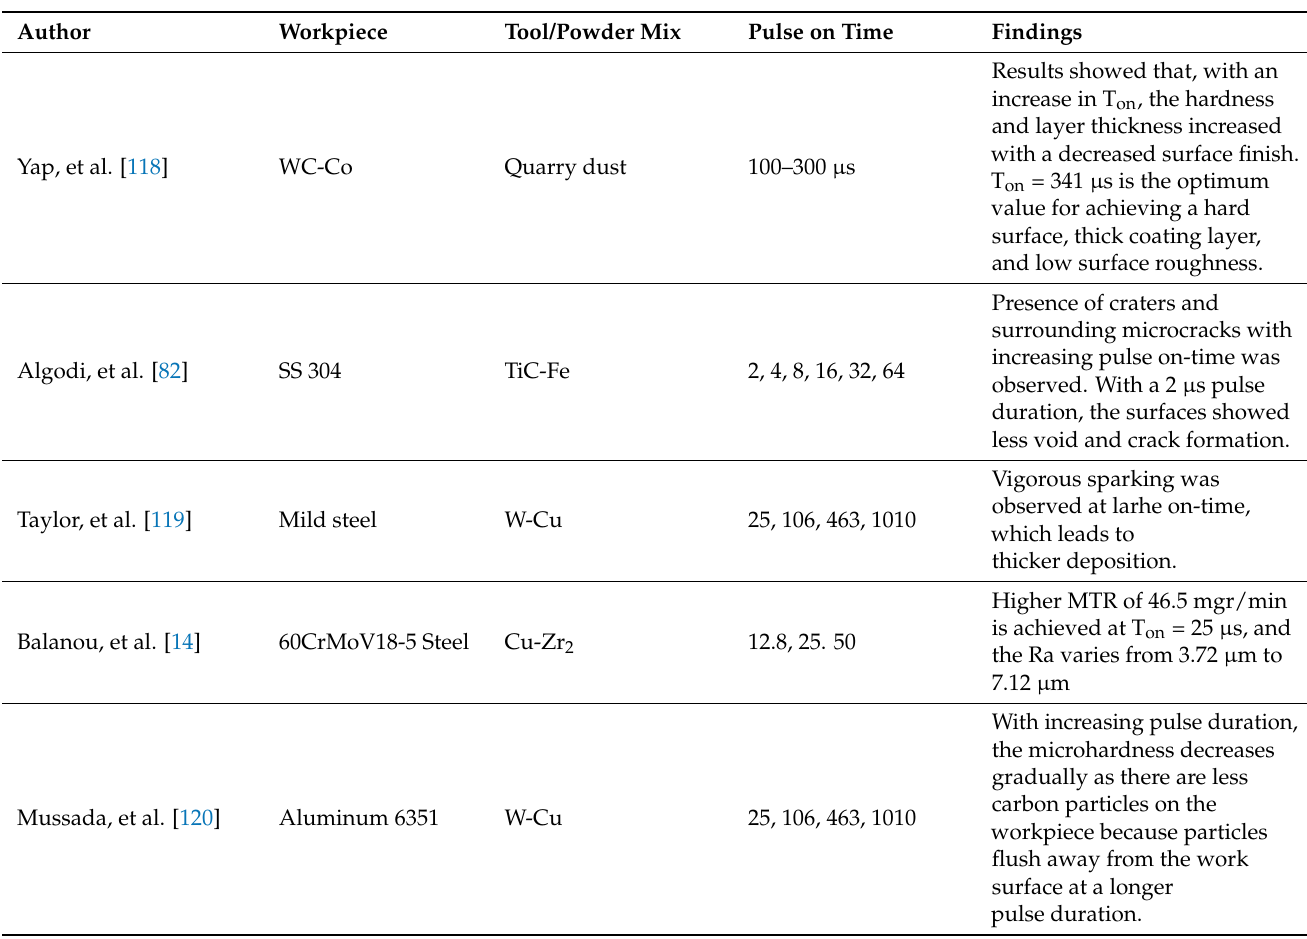
Table 5. The summary of the past literature work on the effect of the pulse